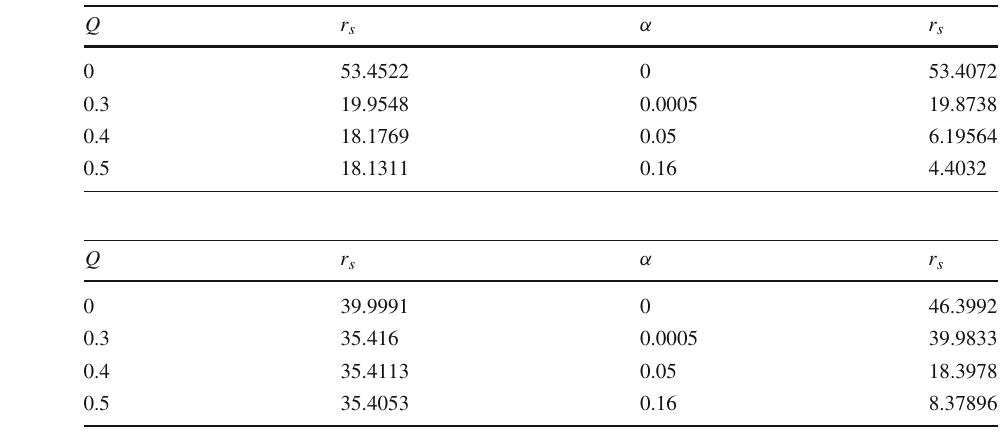
Table 5 Static radius for ω = − 2